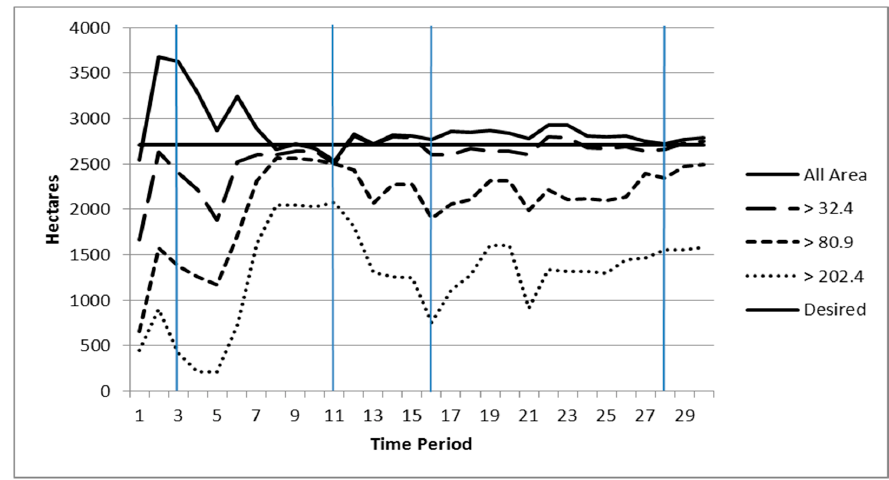
Figure 8. S3 2226 scenario—Kirtland’s warbler habitat area in patches of various minimum sizes relative to total area of habitat (desired and modeled). Vertical lines correspond to the time periods depicted in Figure 7.